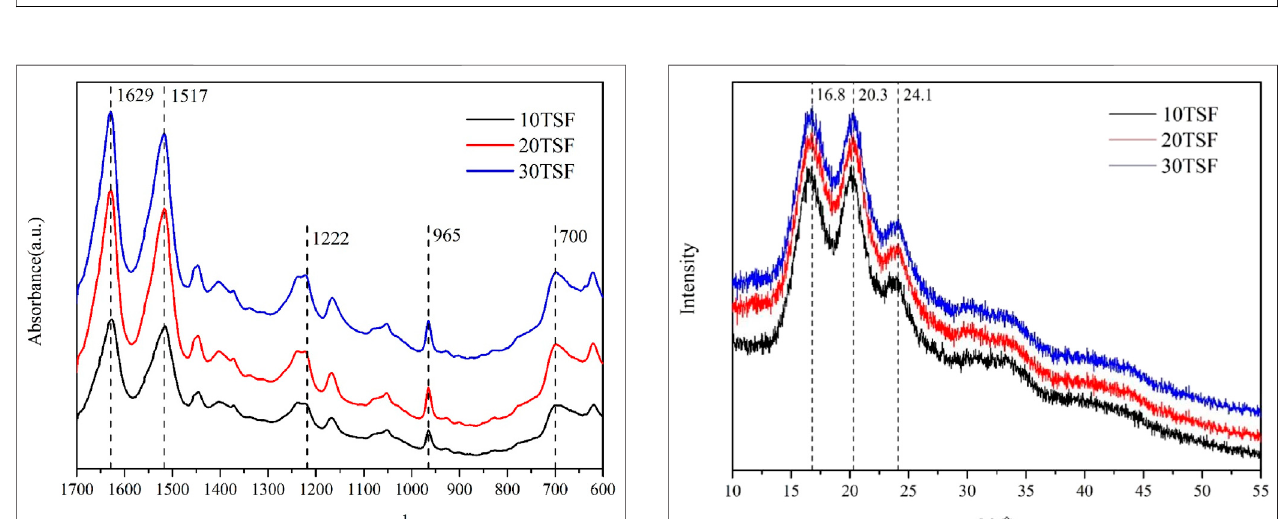
FIGURE 3 | (A) Diameter of the TSF nano fi ber after 10-, 20-, and 30-min physical shearing (* p < 0.05, ** p < 0.01, *** p < 0.001) (B) Optical photos of the TSF nano fi ber solution stored for 0 (B), 15 (C), and 30 (D) days.